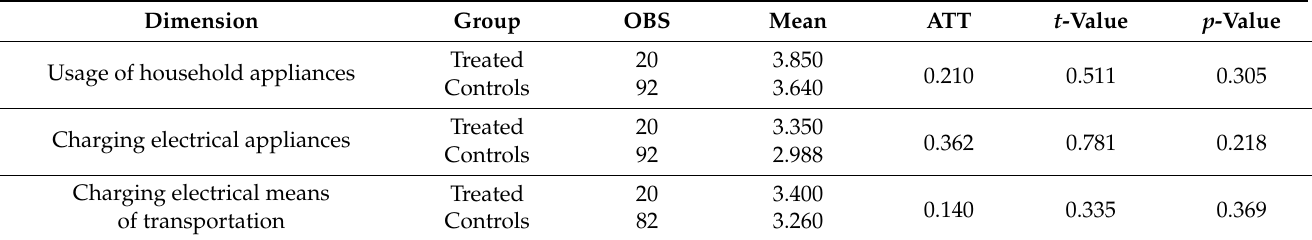
Table 2. Demand flexibility comparisons of Wind-owners (treated) versus Non-Owners (controls) (source: authors’ own